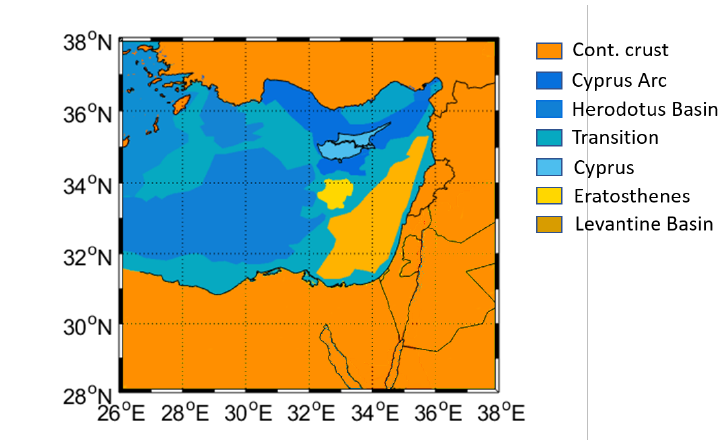
Figure 7. The boundaries of the main geological provinces within the Levant Basin. Colors from yellow to red represent the continental domains, while colors from blue to azure represent the oceanic